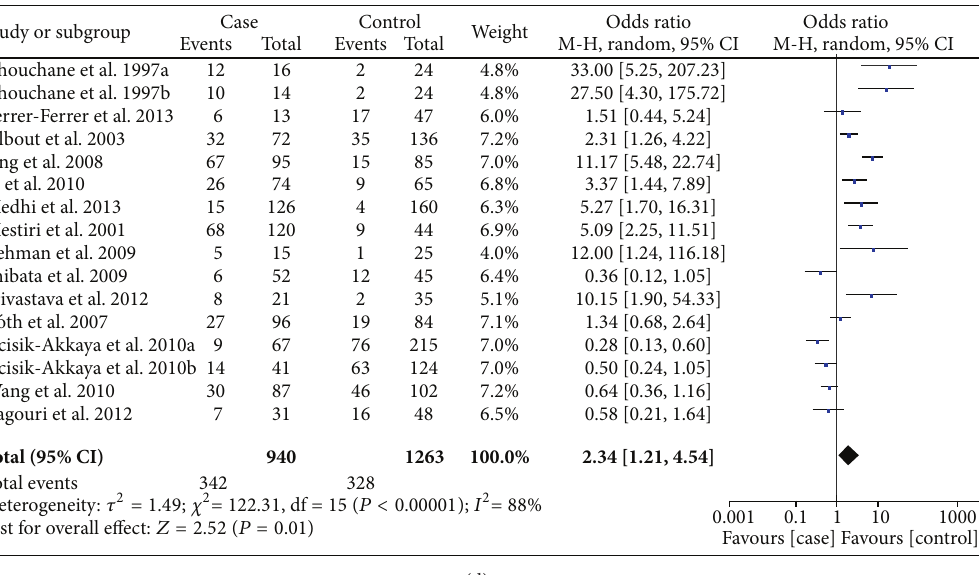
Figure 2: Meta-analysis of the association between HSP70-2 polymorphism and susceptibility to cancer. ((a) dominant model; (b) recessive model; (c) AG versus AA; (d) GG versus